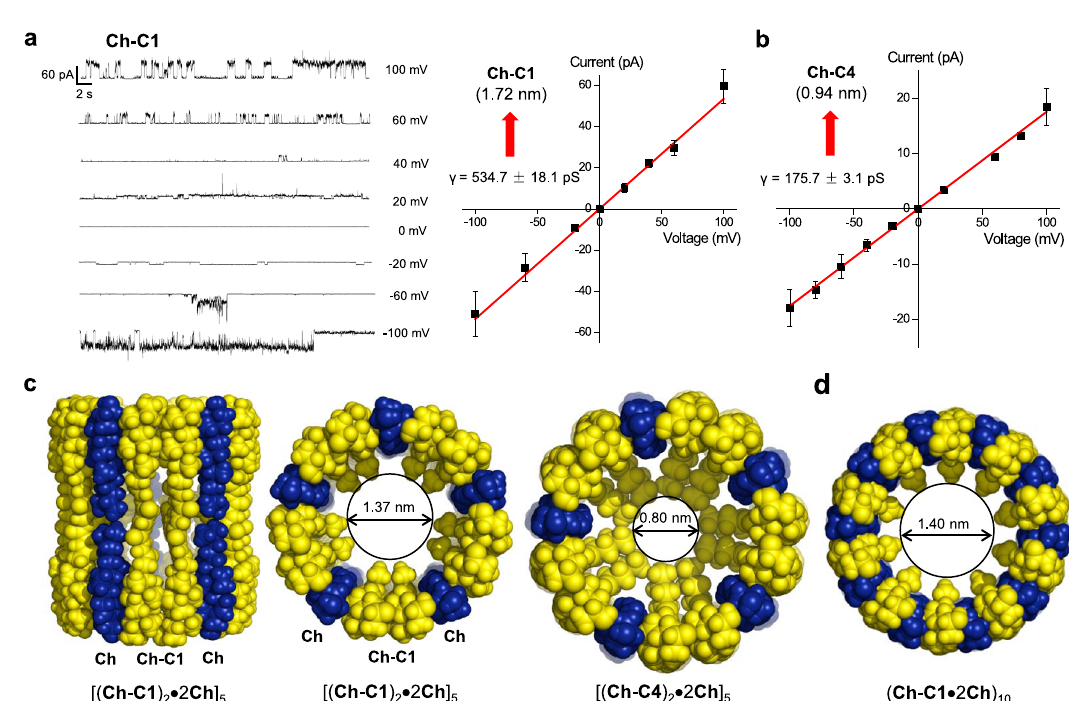
Fig. 3 | Single channel study and molecular dynamic simulation of nanopores. a Singlechannelcurrenttracesof Ch-C1 recordedinsymmetric( cis chamber= trans chamber=1MKCl)baths,theredlinesrefertothemeancurrentvaluesforplotting current-voltage (I-V) curve for obtaining the ion conductance ( γ ) and pore size (1.72nm) for Ch-C1 . b I-V curve and estimated pore size (0.94nm) for Ch-C4 . Data